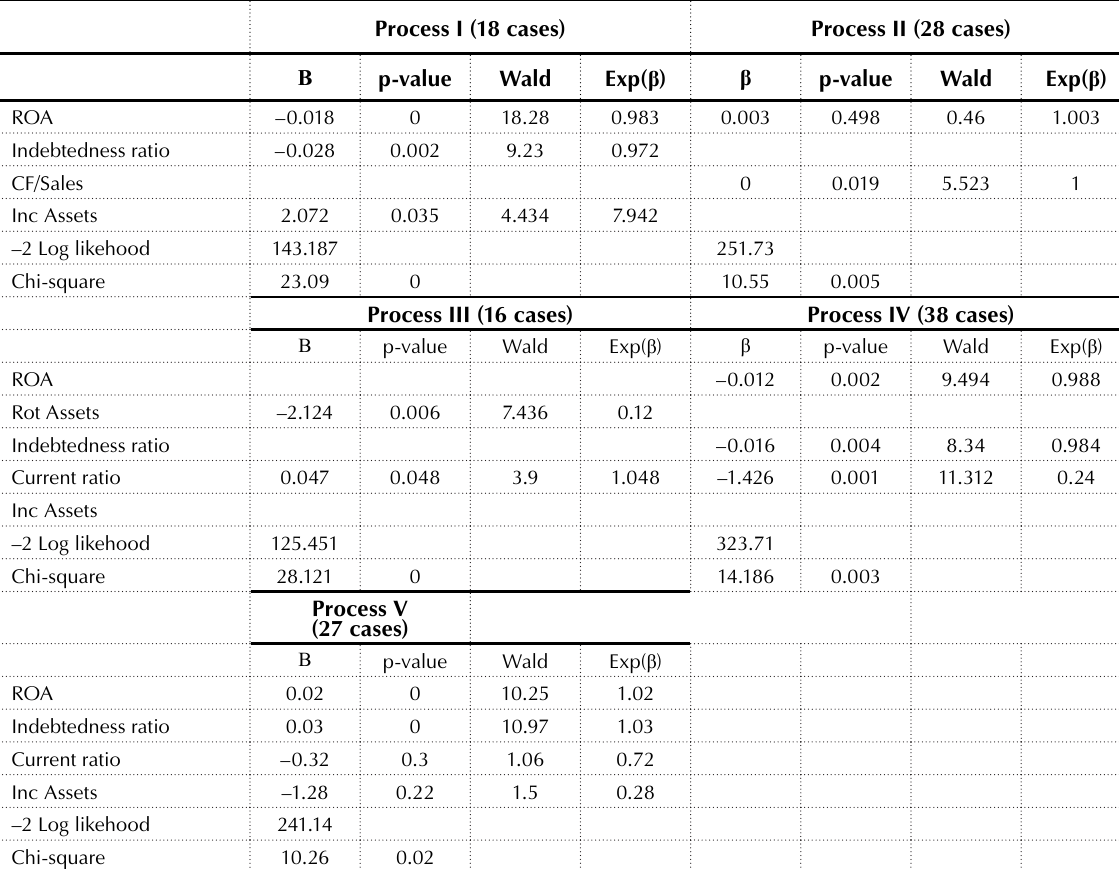
Table 9. Proportional risks function for each processes failure detected in the